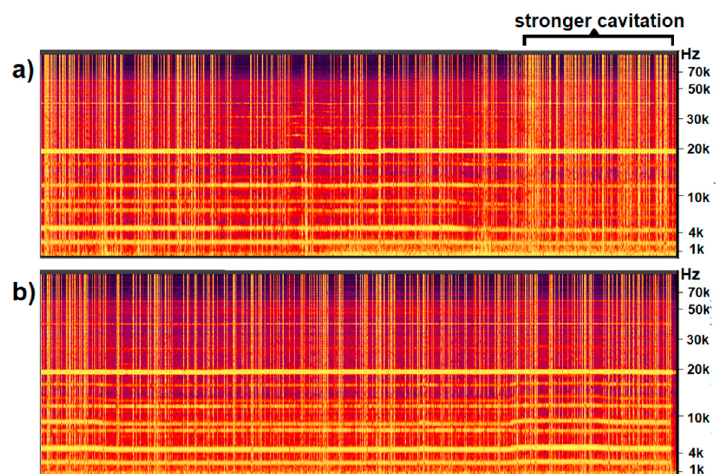
Figure 4. Spectrograms extracted from the recorded sound: ( a ) experiment 1, ultrasonication with frequency 18.86 kHz, and ( b ) experiment 2, ultrasonication with frequency 18.42 kHz. The time of recording in both cases was about 5 min long.